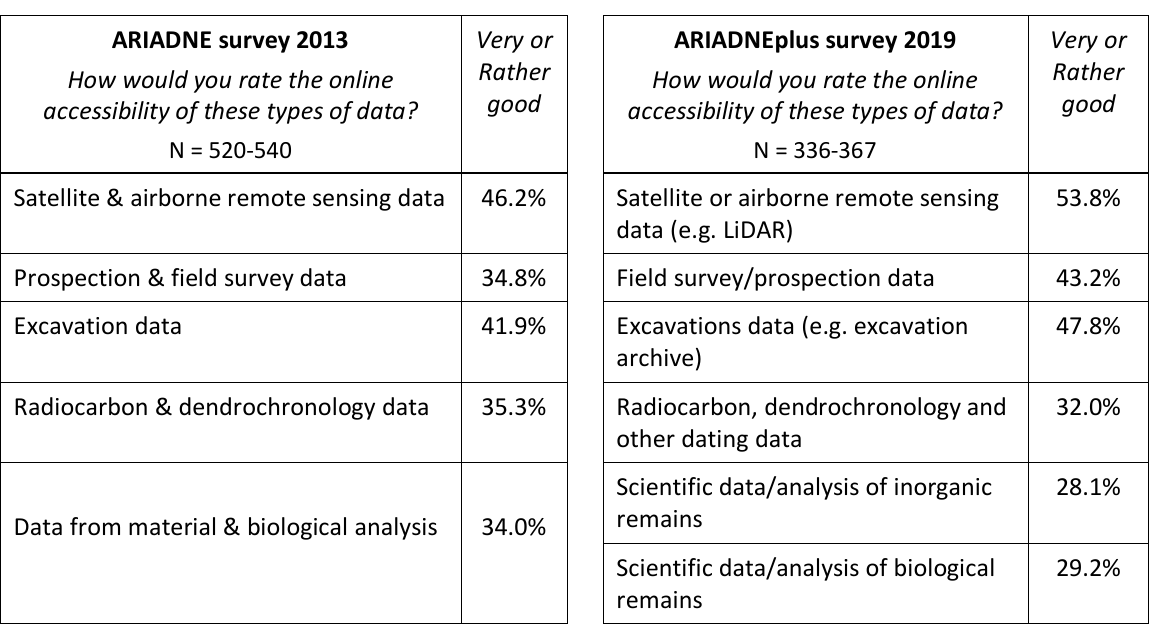
Table 17 : Comparison of the rating of six data types in the ARIADNE/plus 2013 and 2019 surveys (source of the 2013 ratings: ARIADNE 2014: